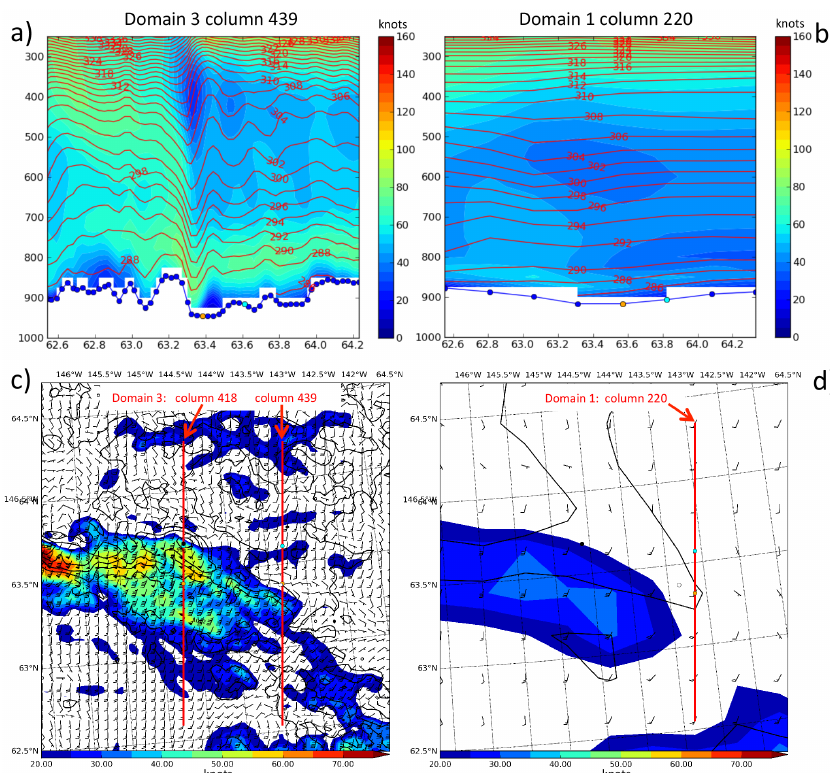
Figure 14. Cross sections valid at 11:00UTC 17 September 2012 of model potential temperature (contoured every 2K) and horizontal wind speed (shaded in knots) for (a) domain 3 and (b) domain 1. Plan-view maps for (c) domain 3 and (d) domain 1 of sea level pressure (SLP, contoured) and 10m wind field (shaded in knots with standard representation of wind barbs; every second grid point shown for domain 3). Red lines near 143 ◦ W in (c) and (d) denote locations of cross sections along grid column 439 of domain 3 and grid column 220 of domain 1, respectively. Model surface pressure trace shown as joined dark blue circles on (a) and (b) . Locations of reference orange and light blue circles on surface pressure trace ( a and b ) are shown in (c) and (d) . Line near 144.5 ◦ W on (c) shows location of cross section in Fig. 15. Locations of Tanacross (63.38 ◦ N, 143.36 ◦ W) and Dry Creek (63.68 ◦ N, 144.60 ◦ W) denoted by a black-outlined circle and solid black circle, respectively, in (c) and (d)